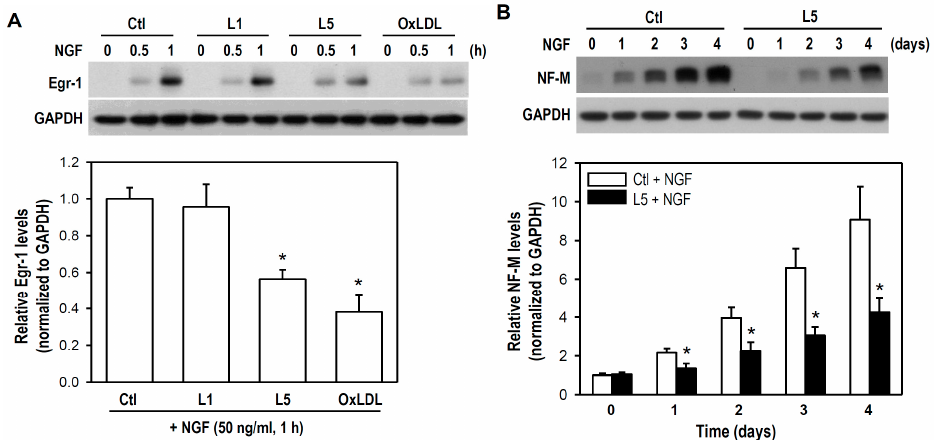
Figure 6. L5 inhibits NGF-induced upregulation of Egr-1 and NF-M. ( A ) Cultures were treated with or without the indicated LDLs (10 μ g/mL) for 1 h, followed by NGF (50 ng/mL) addition for the indicated time periods. Cells untreated with LDLs were used as a control. Egr-1 expression was detected by western blotting (representative blot is shown). GAPDH was a protein loading control. The histogram shows relative Egr-1 expression values of each treatment group at a time point of 1 h. Data are presented as mean ± SEM from four independent experiments. * p < 0.05 vs. Ctl + NGF; and ( B ) Cultures were treated with L5 (10 μ g/mL) for 1 h, followed by NGF (50 ng/mL) addition for another times (days) as indicated. Cells untreated with LDLs were used as a control. Western blotting was performed to detect NF-M expression (representative blot of NF-M is shown). The histogram shows relative NF-M levels between Ctl + NGF and L5 + NGF groups from day 0 to 4. Data are from four independent experiments. * p < 0.05 vs. Ctl + NGF on the same day.